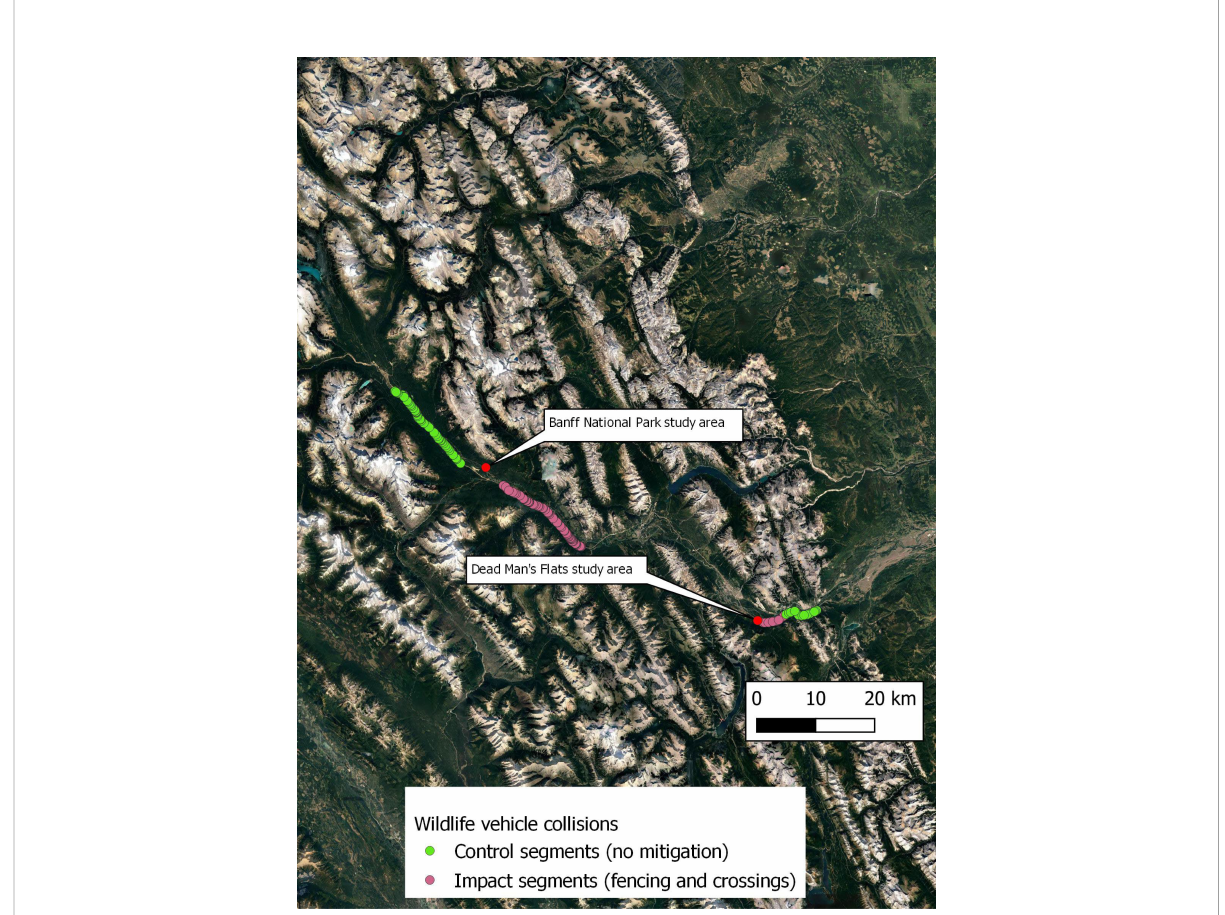
FIGURE 1 Map showing the location of wildlife vehicle collisions along the Trans-Canada Highway in Banff National Park [top] and Dead Mans Flats [bottom], AB, Canada between 1998 and 2010. Green points represent the location of collisions in the control section and purple points are the location of collisions in the impact